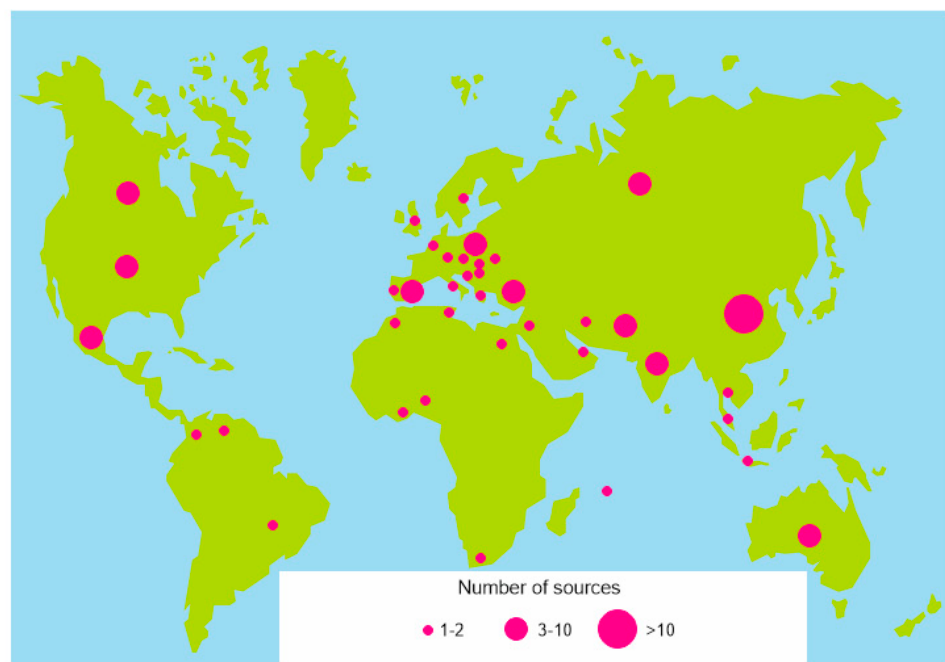
Figure 3. Geographical spreading of the authors of the studies under review. See Table 1 for data.